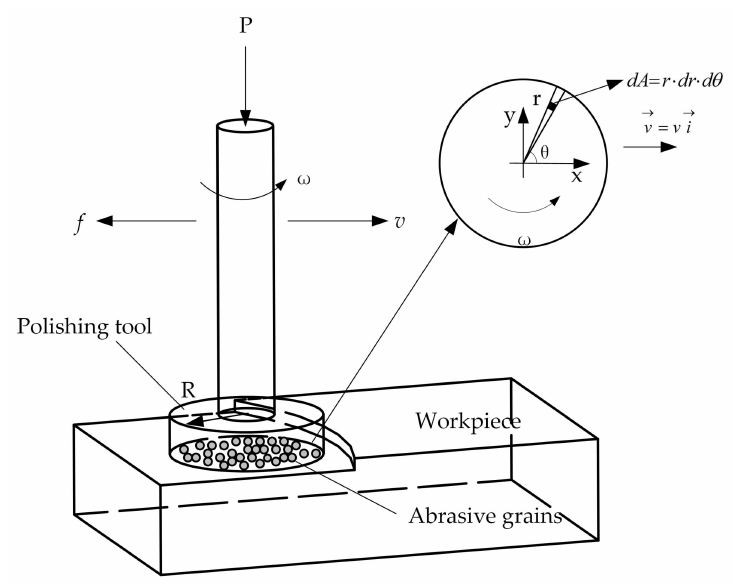
Figure 4. Schematic diagram of the motion between the polishing tool and the